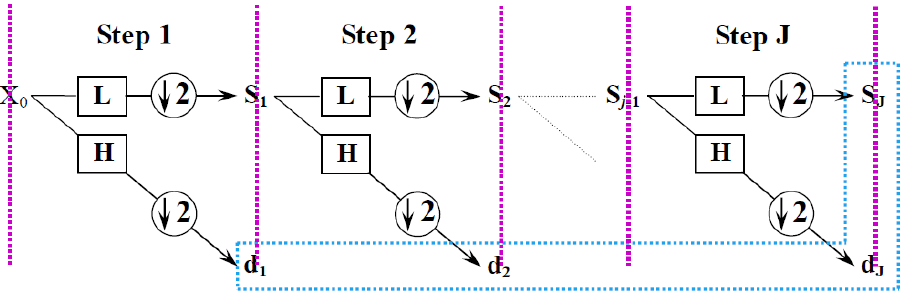
Figure 4. Schematic of the fast wavelet transform